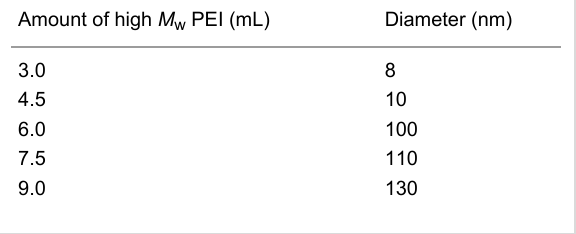
Table 3: The dependence of the SnO 2 particle diameter on the amount of PEI ( M w = 750 000). The amount of Triton X-100 was held constant. Amount of high M w PEI (mL) Diameter (nm)